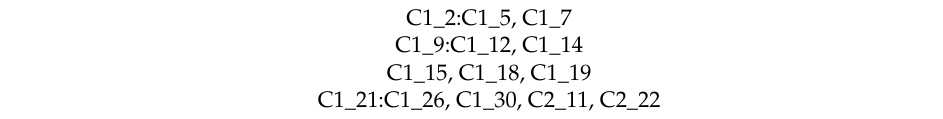
Table 6. Features with weight value < 1/ m despite the FW